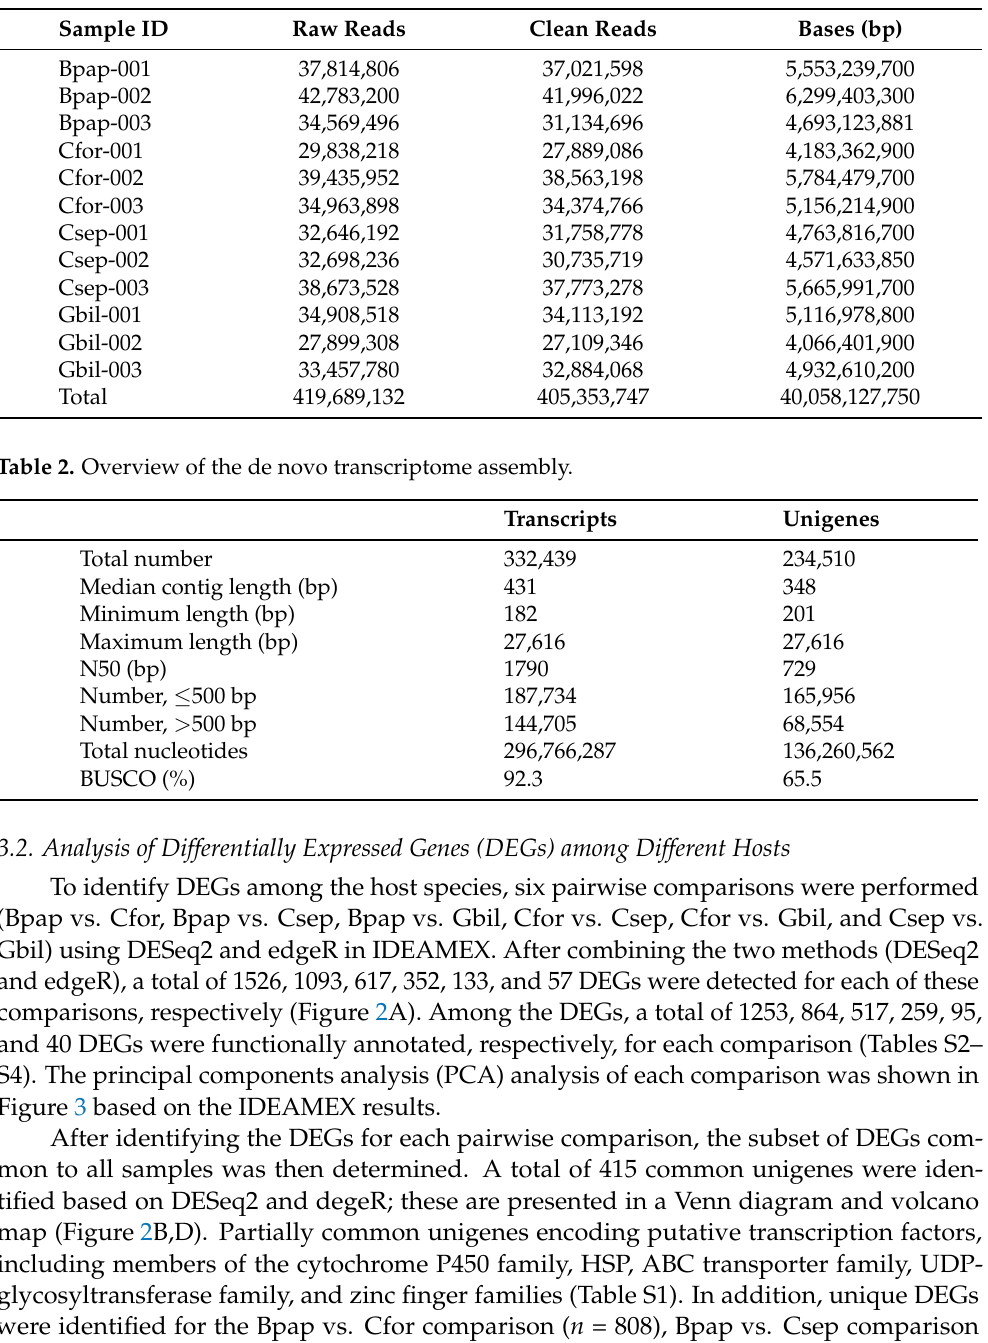
Table 1. Summary of T. nigrans RNA-sequencing data analyzed in this study.